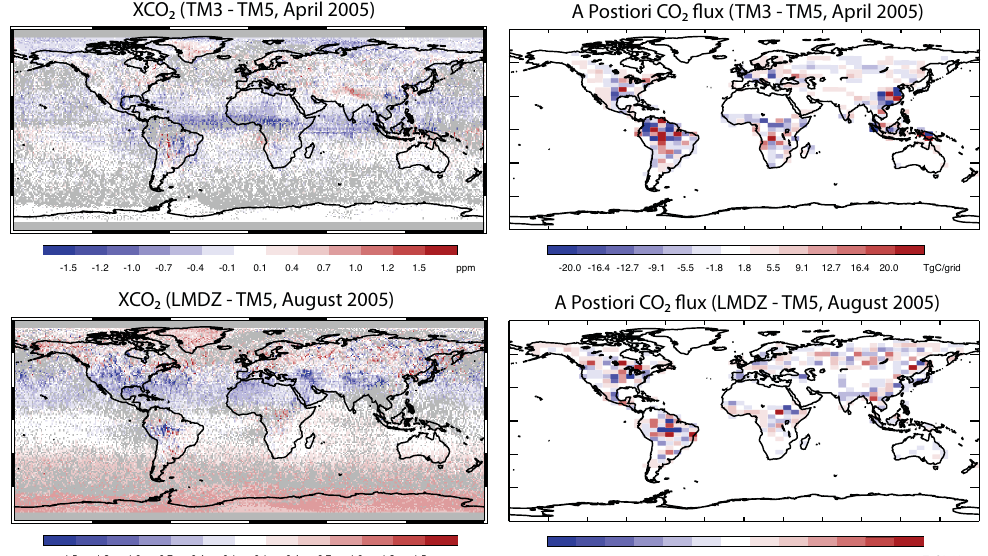
Fig. 6. Examples of the inversion-derived mapping of concentration differences to flux differences. Top panels: TM5 inversion using TM3-derived x CO 2 samples for April. Bottom panels: TM5 inversion using LMDZ-derived x CO 2 samples for